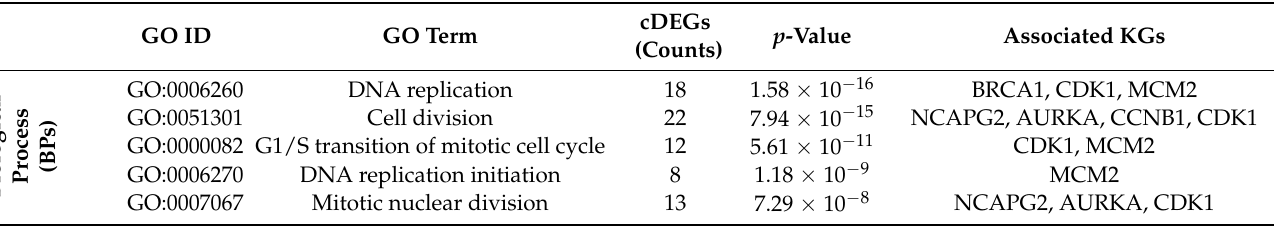
Table 1. The top five significantly ( p -value < 0.001) enriched GO functions and KEGG pathways by cDEGs involving KGs with CC diseases.